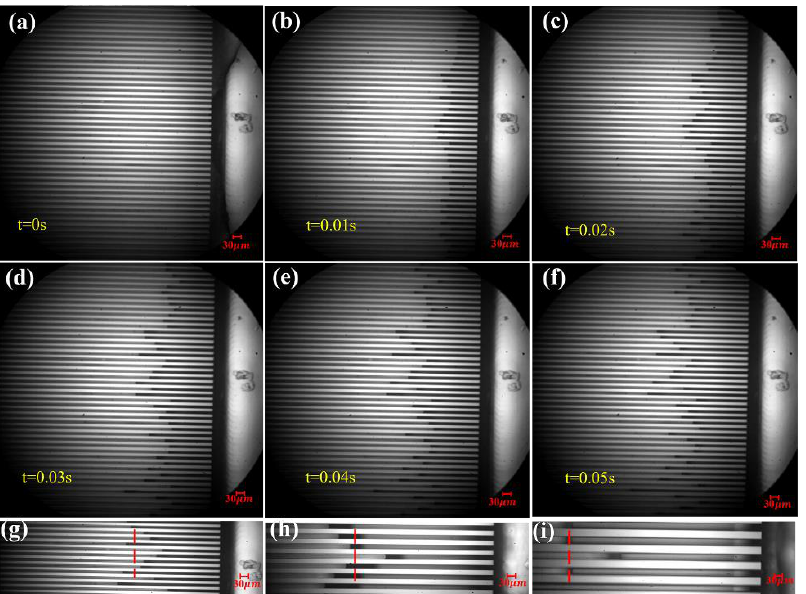
Figure 4. Microchannel suction phenomenon diagram. ( a – f ) The capillary suction process in the 12 µ m microchannel; ( g ) The 12 µ m microchannel suction termination diagram; ( h ) The 20 µ m microchannel suction termination diagram; and ( i ) The 30 μm microchannel suction termination diagram.